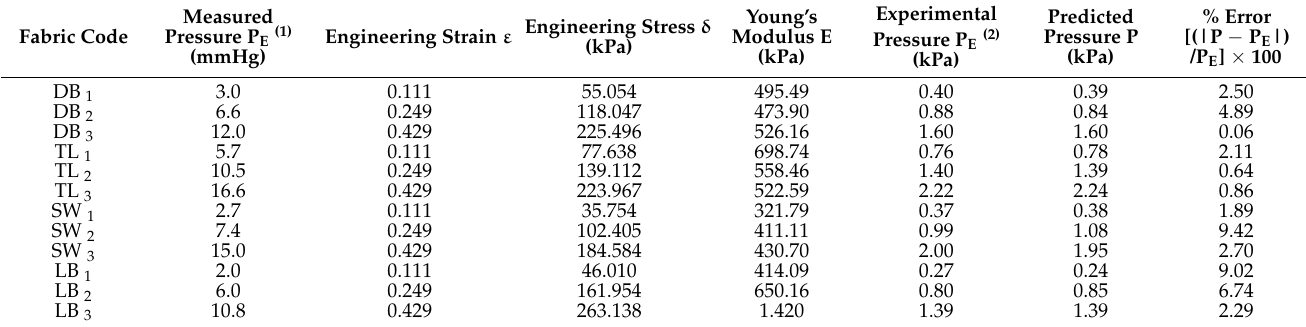
Table 3. Measurement of engineering strain, stress, modulus and predicted compression. Fabric Code